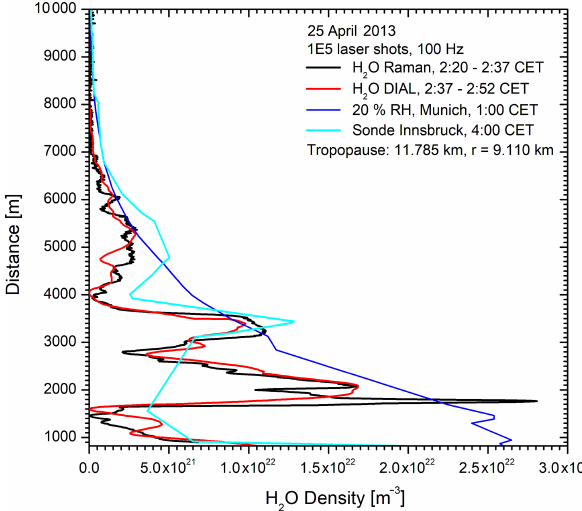
Figure 9. Comparison of consecutive measurements of the Raman lidar and DIAL at UFS on 25 April, 2013: the sonde measurements at Munich (not shown) and Innsbruck strongly differ from those of the lidar systems. For comparison, we show the densities corre- sponding to 20% RH as calculated from the Munich